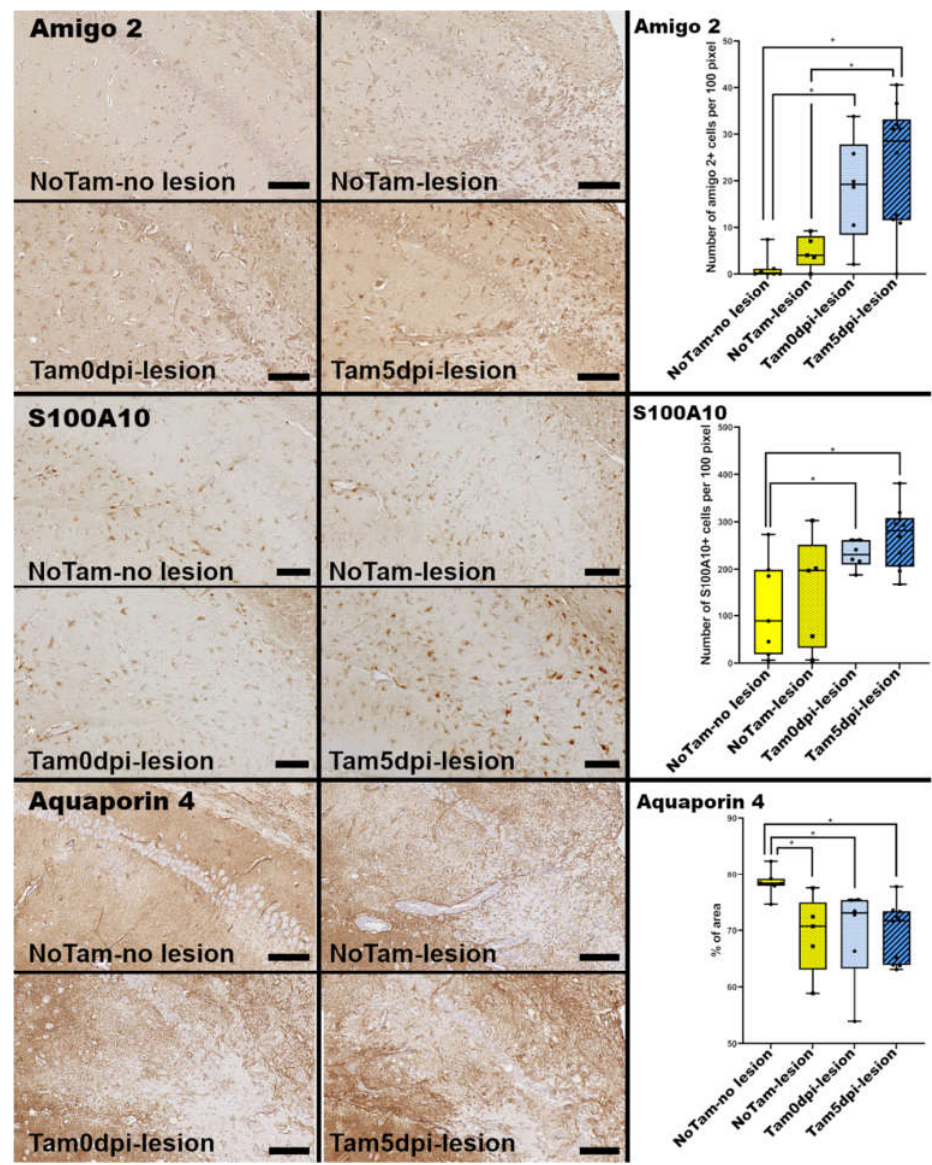
Figure 4. Immunohistochemical evaluation of hippocampi of Theiler’s murine encephalomyelitis virus BeAn (TMEV-BeAn) infected mice 14 days post-infection (dpi). Further differentiation of the astrocyte phenotypes into amigo 2-positive cytotoxic A1 astrocytes and S100A10-positive neurotrophic A2 astrocytes revealed an increase of both phenotypes in tamoxifen-treated animals. The number of cytotoxic A1 astrocytes was higher in tamoxifen-treated animals compared to untreated animals with hippocampal neuronal loss. Aquaporin 4 expression was downregulated in the presence of inflammation but was not further impacted by tamoxifen application. Scale bars: 100 µm (Amigo 2, S100A10, Aquaporin 4). Statistical significant differences are depicted as * = p ≤ 0.05 (Supplementary Table S1 for each p -value individually).